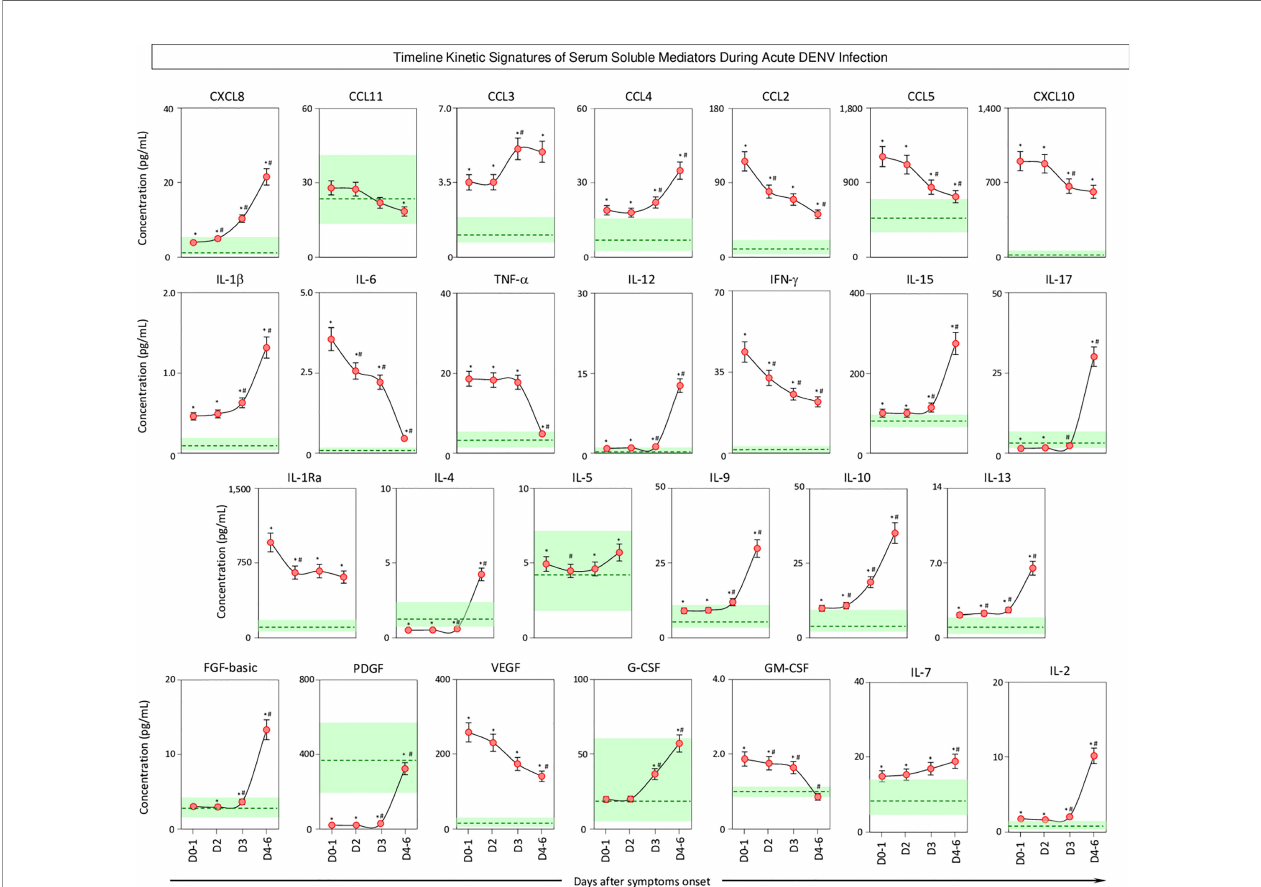
FIGURE 5 | Timeline kinetics of serum soluble mediators during acute DENV infection. The dynamic kinetics of chemokines (CXCL8, CCL11, CCL3, CCL4, CCL2, CCL5, CXCL10), pro-in fl ammatory cytokines (IL-1 b , IL-6, TNF- a , IL-12, IFN- g , IL-15, IL-17), regulatory cytokines (IL-1Ra, IL-4, IL-5, IL-9, IL-10, IL-13), and growth factors (FGF-basic, PDGF, VEGF, G-CSF, GM-CSF, IL-2, and IL-7) was characterized in serum samples from patients with acute DENV infection ( n=313) by cross-sectional analysis at four consecutive time points (Days = D), including: D0-1 (n=89), D2 (n=100), D3 (n=71), and D4-6 (n=53) after symptom onset. Measurements were carried out by a high-throughput microbeads array as described in the Material and Methods section. The results are presented as a line chart of median values (± 10% of median) at each time point along with the timeline kinetics. The green zone represents the reference interquartile range (25 th -75 th ) observed for non-infected healthy controls “ NI ” (n=319). Signi fi cant differences at p<0.05 are identi fi ed by asterisks (*) for comparisons with “ NI ” and (#) for comparisons with the immediately preceding